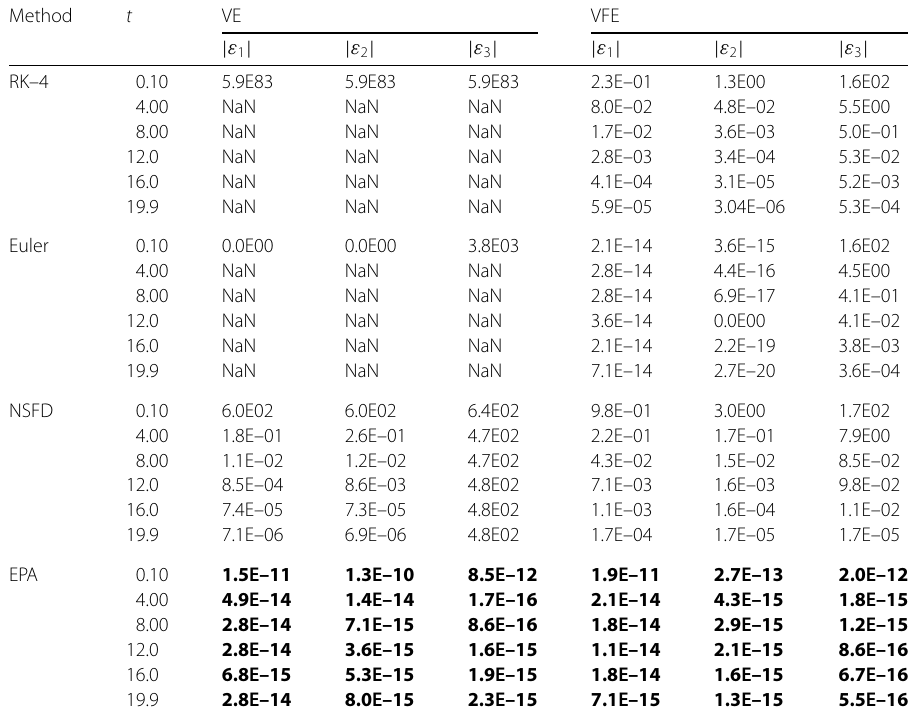
Table 4 Absolute residuals for h =